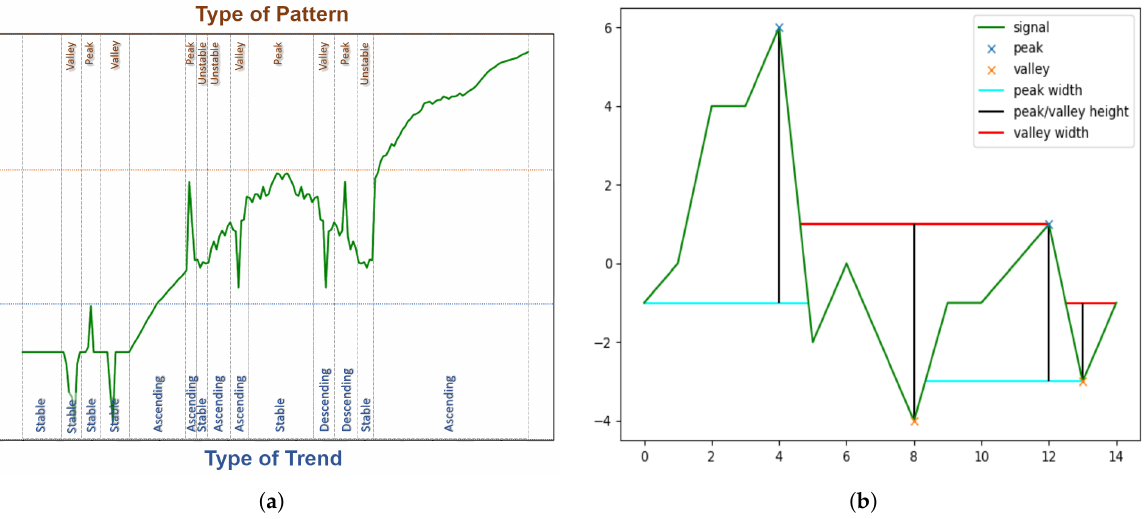
Figure 2. Examples of trends and patterns combinations and peaks and valleys detected by our algo- rithm. ( a ) Combinations of trends and pattern types in visual selections. ( b ) Peaks and valleys